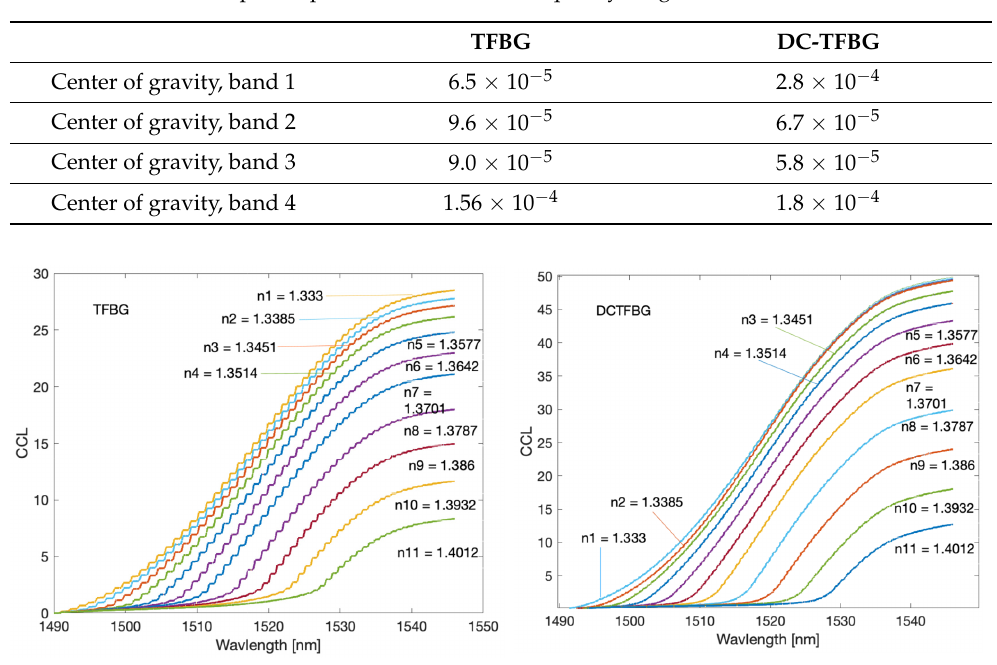
Sensors 2022 , 22 , x FOR PEER REVIEW Figure 16. Cumulative spectrum contour for TFBG and DC-TFBG. Figure 16. Cumulative spectrum contour for TFBG and DC-TFBG.